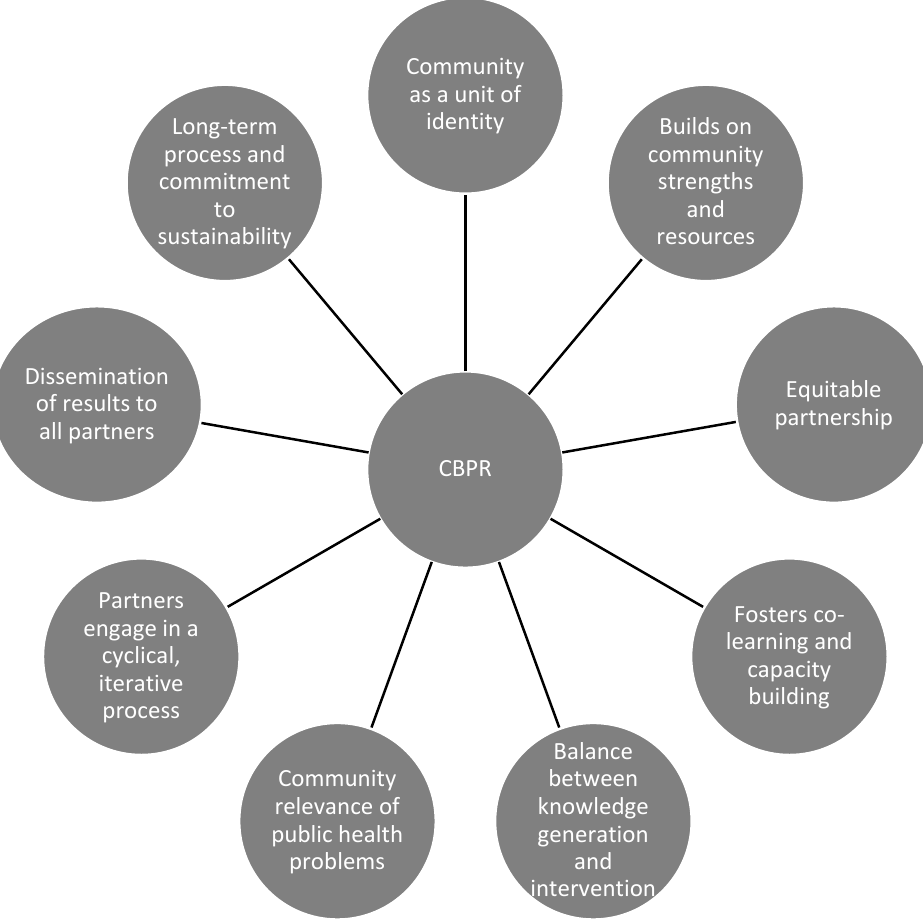
Figure 1. The key principles of Community–Based Participatory Research (CBPR). Adapted from “Methods for Community-Based Participatory Research for health” [18] (pp. 9–11).